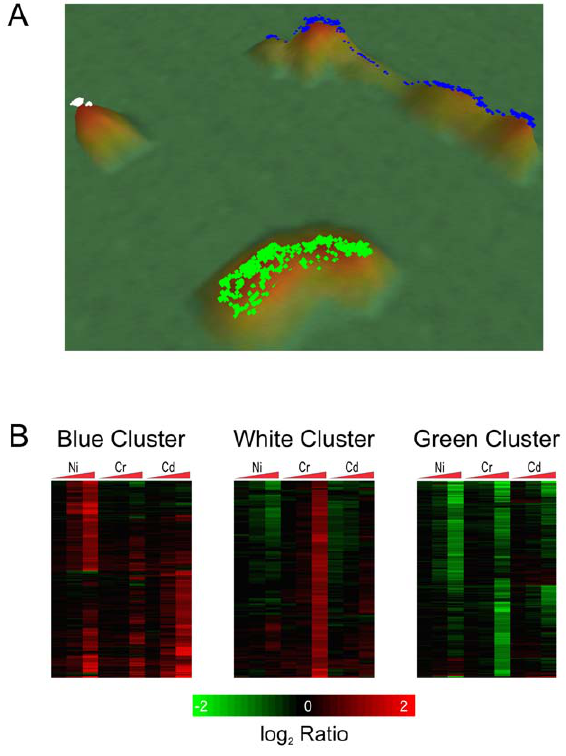
Figure 4. Cluster analysis of 992 differentially expressed probe sets. (A) Cluster analysis of all differentially expressed probe sets was performed using VxInsight, which clusters together probe sets with similar expression patterns, suggesting they may be co-regulated. Each colored point represents one probe set, and the height of each peak is proportional to the number of data points beneath it. Probe sets with similar expression patterns among the metal exposures cluster closely together while those that are different are further apart. Three clusters are indicated by white, blue, and green dots. (B) The expression patterns are depicted by the heat map with the triangles indicating increasing concentrations of metals and the color indicating the log 2 ratio of control to experimental expression levels. The white cluster is comprised almost entirely of probe sets up-regulated by exposure to